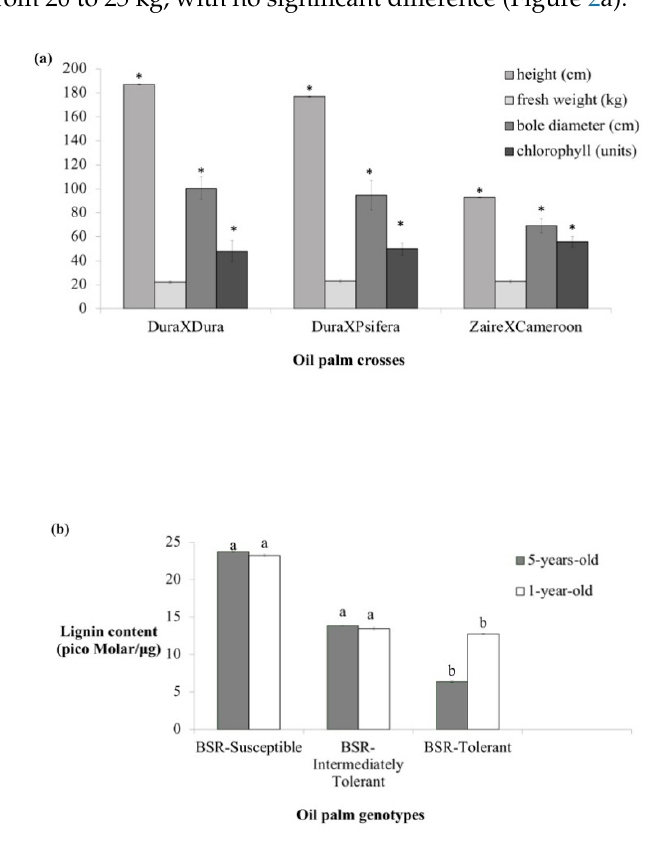
Figure 2. Characterization of plant functional traits in one-year-old oil palm seedlings ( a ) and root seedlings. ( b ) Root lignin content by oil palm crosses / genotyes in one and five-year old seedlings / lignin content by oil palm crosses/genotyes in one and five-year old seedlings/trees ( b ). The oil palm genotypes are described as following: BSR-susceptible; DuraXDura; BSR-intermediately; DuraXPsifera and DeliXPsifera and BSR-tolerant; ZaireXCameroon and DuraXCameroon. Values are expressed as average mean±standard deviation of thirty biological replicates. Asterisks represent presence of significant difference among the oil palm genotypes at p < 0.05 .